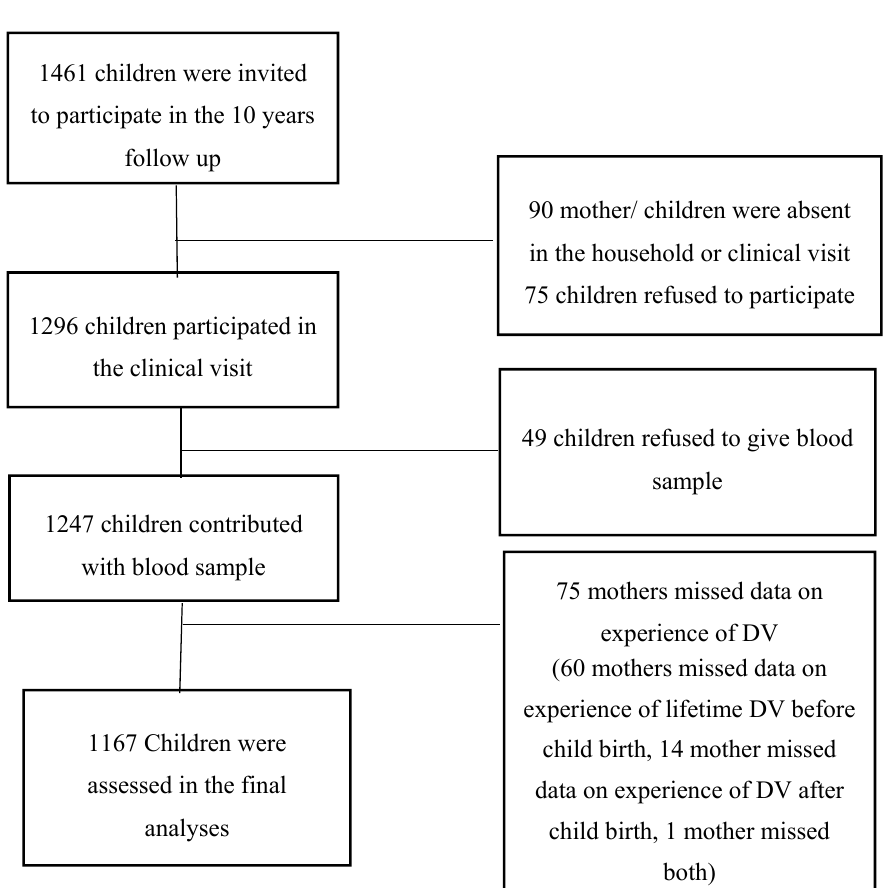
Figure 1. Fellow chart of participating children and their mothers.